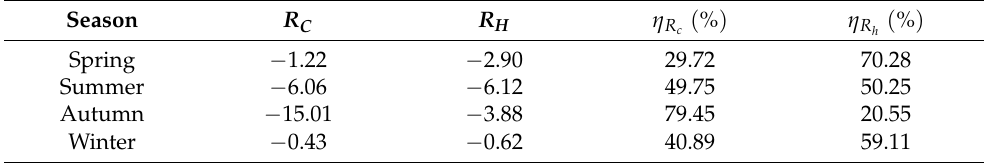
Table 5. The attribute analysis of seasonal runoff change in